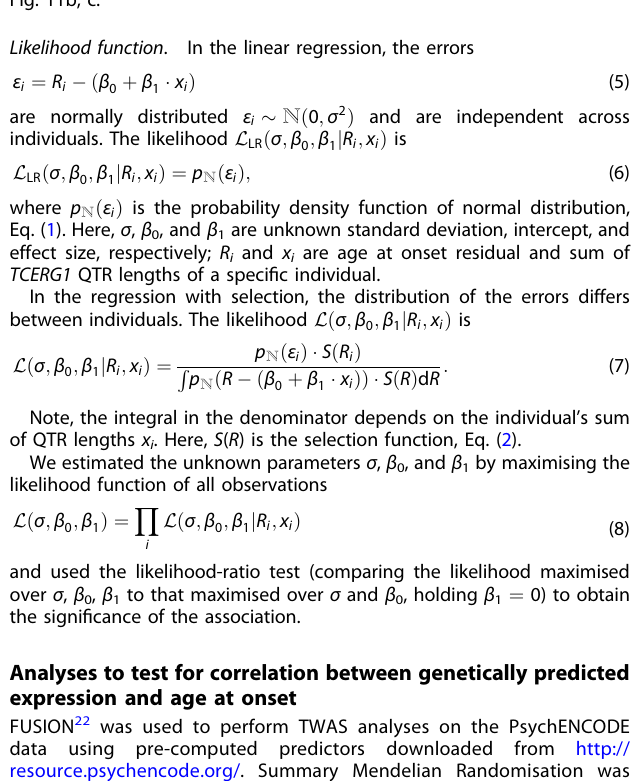
Supplementary Fig. 11a. The one-sample Kolmogorov – Smirnov p -value is 0.81. The selection and probability densities are shown in Supplementary Fig. 11b, c. Likelihood function . In the linear regression, the